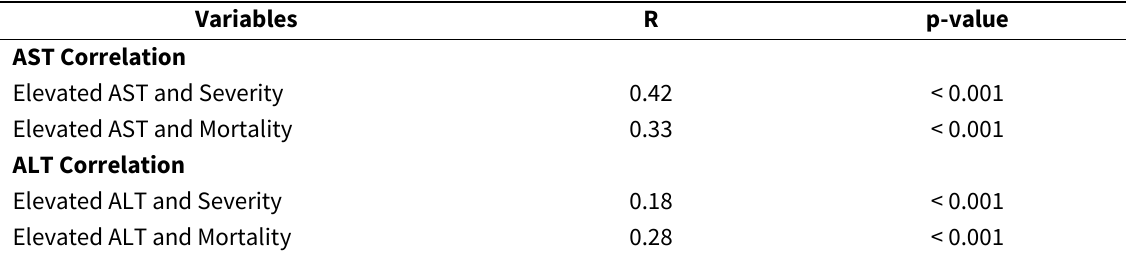
Table 4 . Pearson Correlation Test for Increased